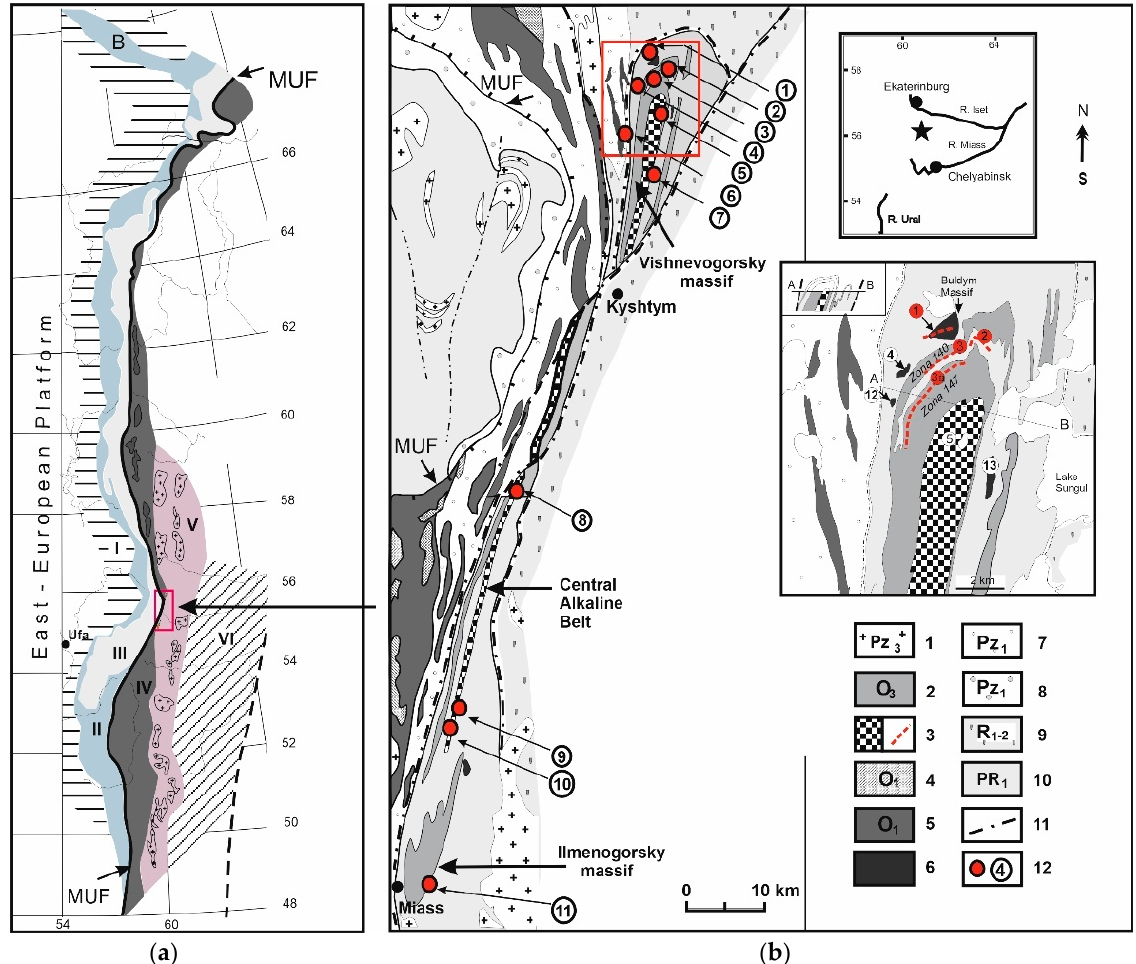
Figure 1. ( a ) Tectonic scheme of the Urals, after [55]. Tectonic zones: I—Preuralian foredeep (evaporites, molasse, flysch, Pz); II—West Ural megazone (sediments of the passive continental margin, O-P); III—Central Ural megazone (metasedi- ments and volcanic rocks, Rf, with crystalline basement ledges, AR-PR 1 ); MUF—suture zone of the Main Ural Fault (ser- pentinites, megabreccias, high pressure rocks (eclogites, etc.), mafic–ultramafic complexes, O-D); IV—Tagilo-Magnito-